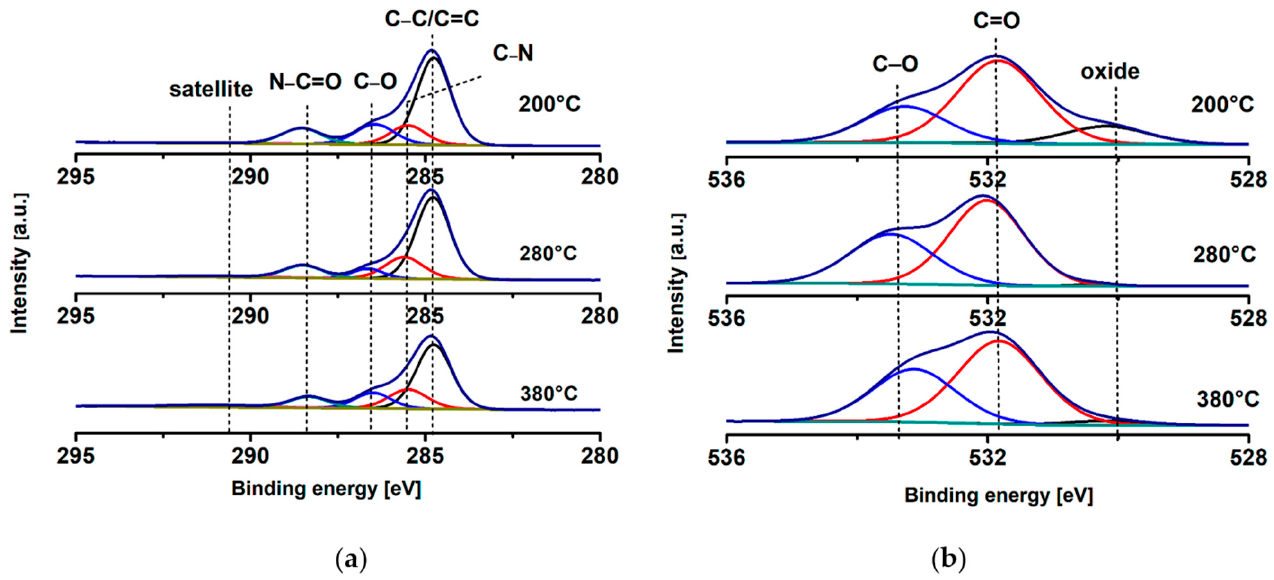
Figure 2. High-resolution XPS scans of ( a ) C 1s, ( b ) O 1s.